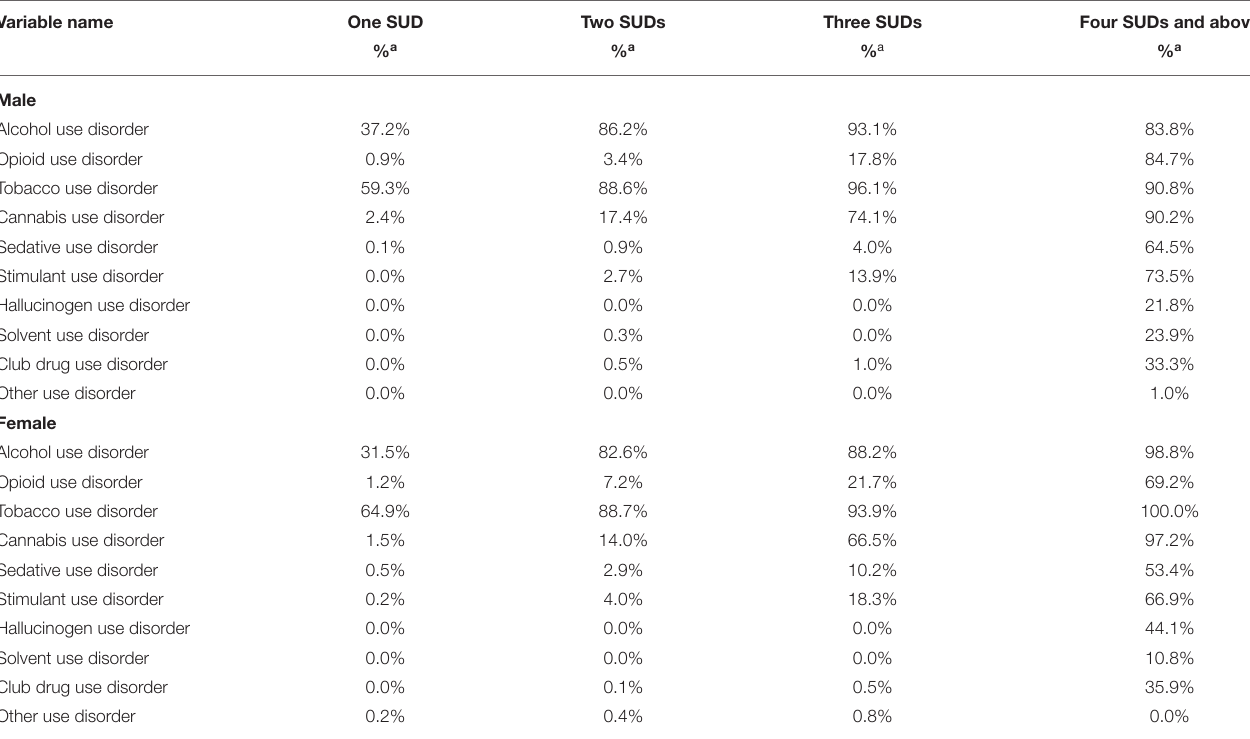
TABLE 3 | The prevalence of specific substance use disorder (SUD), by sex and by number of